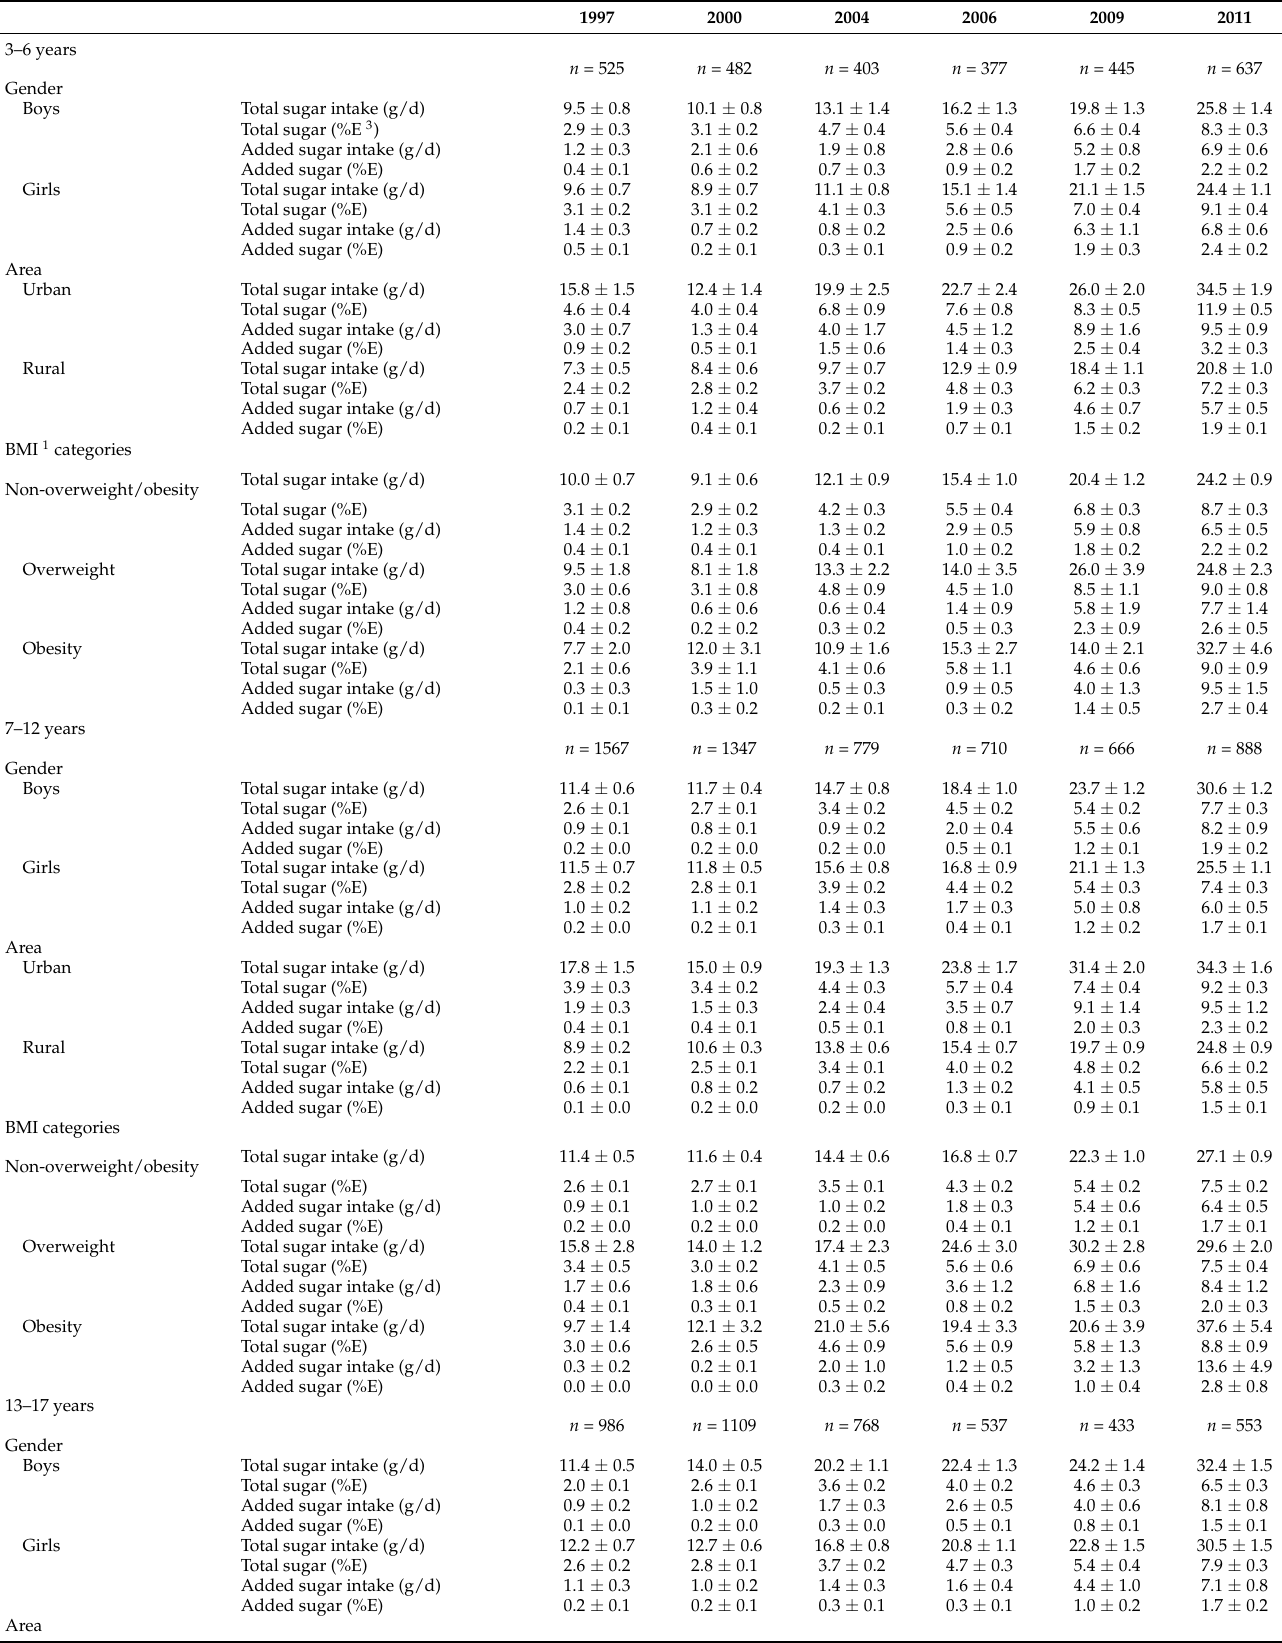
Table 3. Trends in total and added sugar intakes by gender, area, and BMI 1 categories among children and adolescents by age groups, CHNS 2